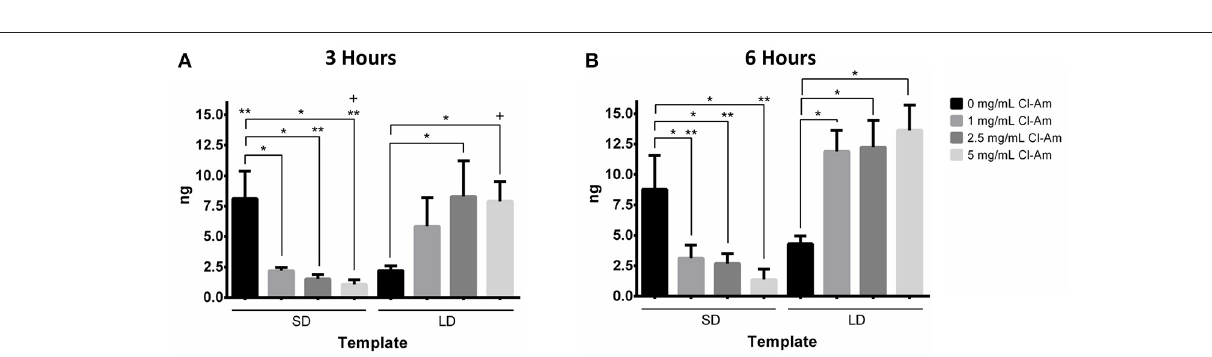
FIGURE 8 | Cl-Am significantly decreases template-bound CitH3 on SD templates. Template-bound CitH3 at (A) 3 and (B) 6h suggests that template architecture and Cl-Am concentration regulate NETosis. *Significant difference ( p < 0.05). **Significant difference between SD and LD templates ( p < 0.05). + Significant difference between 3 and 6h ( p < 0.05) (mean ± std. dev., n =